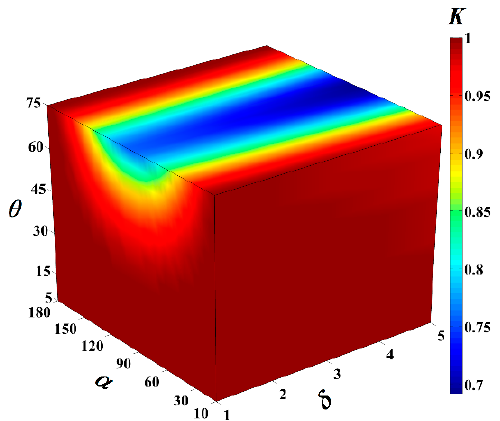
Figure 5. The contrast of two-beam non-coplanar interference at different incident angles, azimuth angles, and polarization angle deviations. The polarization mode of the incident light beam is the maximum co-directional polarization component.